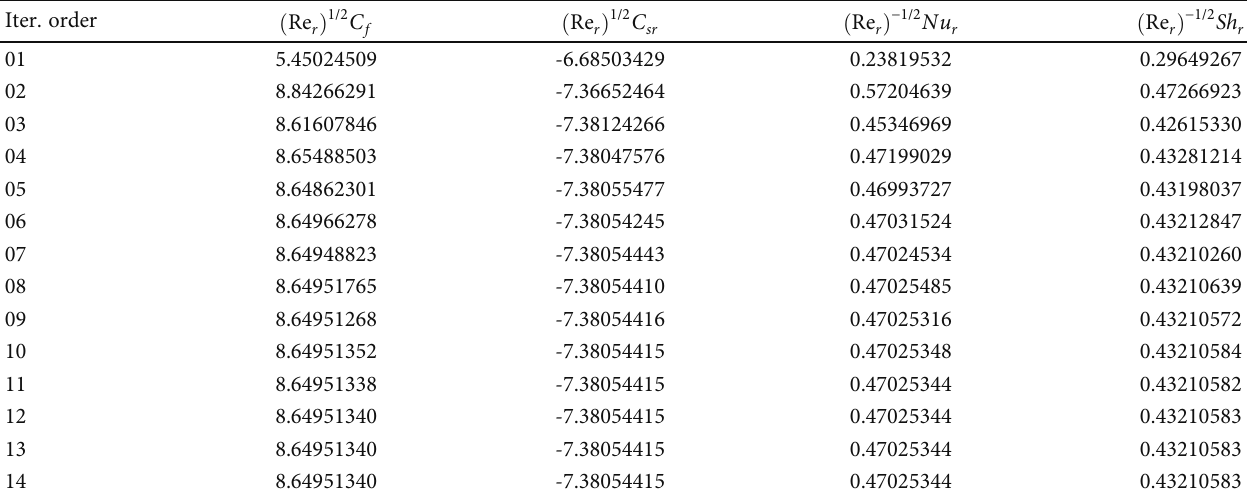
Table 1: SLLM solution convergence test.